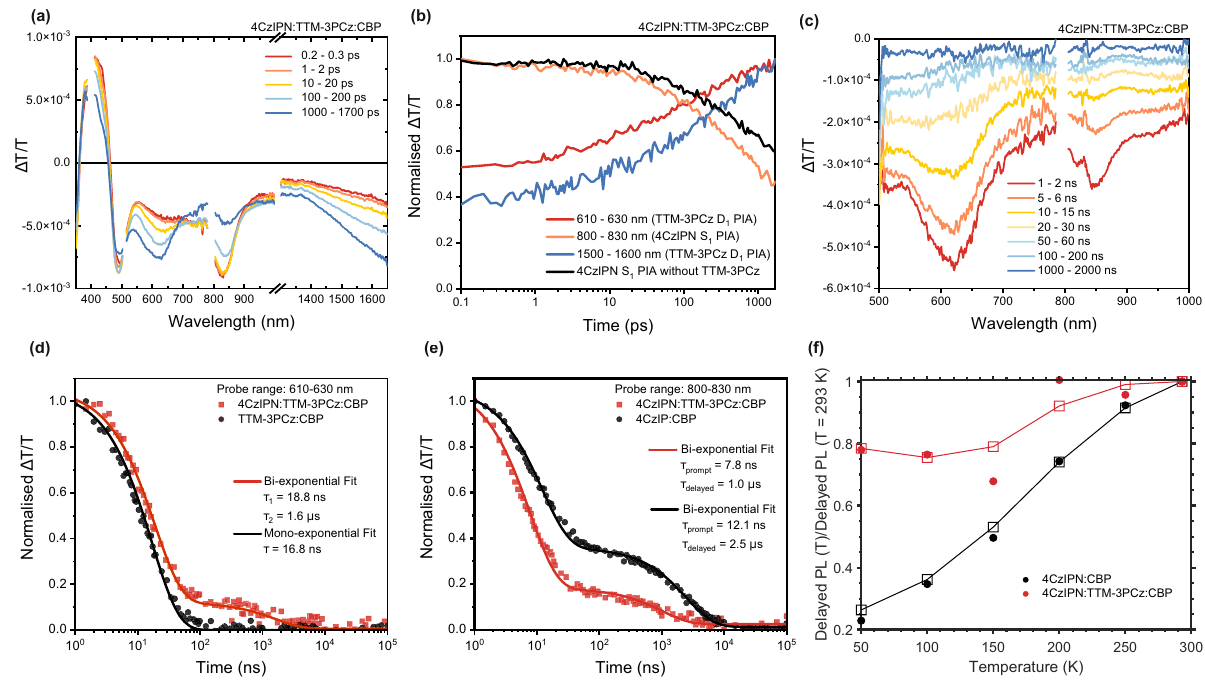
Fig. 3 Transient absorption and temperature dependence studies of 4CzIPN and TTM-3PCz. Picosecond to nanosecond ( a ) timeslices and ( b ) kinetic pro fi les from transient absorption studies of 4CzIPN:TTM-3PCz:CBP (ratio = 0.25:0.03:0.72). 400 nm excitation, fl uence = 89.1 μ J/cm 2 . This shows the decay of the singlet PIA around 830 nm and the growth of the radical PIAs around 620 and 1650 nm. c Nanosecond to microsecond timeslices of the 4CzIPN:TTM-3PCz:CBP blend (0.25:0.03:0.72). 355 nm excitation, fl uence = 17.0 μ J/cm 2 . Discontinuities in timeslice spectral pro fi les for ( a ) and ( c ) arise because multiple experiments are used to cover the studied wavelength probe regions. Transient absorption kinetic pro fi les for photoinduced absorption features of ( d ) TTM-3PCz (610 – 630 nm) and ( e ) 4CzIPN (800 – 830 nm). d TTM-3PCz excited-state kinetics are shown for 4CzIPN:TTM-3PCz:CBP (0.25:0.03:0.72, red squares); and TTM-3PCz:CBP (0.03:0.97, black circles). This shows delayed radical emission is active in 4CzIPN:TTM-3PCz:CBP (TADF:radical) from triplet – doublet energy transfer. e 4CzIPN excited-state kinetics are shown for 4CzIPN:TTM-3PCz:CBP (red squares); and 4CzIPN:CBP (0.25:0.75, black circles). This shows delayed radical emission in 4CzIPN:TTM-3PCz:CBP (TADF:radical) is more rapid than delayed emission in 4CzIPN:CBP (TADF only). Mono- and bi-exponential fi ts are indicated by solid lines in ( d and e ). f Ratio of integrated delayed PL contribution for 4CzIPN:CBP (black circles) and 4CzIPN:TTM-3PCz:CBP (red circles) at different temperatures. Three-point moving average and trends for these pro fi les are indicated by square and line plots, and show different temperature dependencies. in 4CzIPN:TTM-3PCz:CBP, the resulting TA pro fi les resemble TTM-3PCz:CBP, showing that the D exciton — once formed — 1 does not interact with 4CzIPN by further energy or charge transfer processes (Supplementary Figs. 5 and 6).